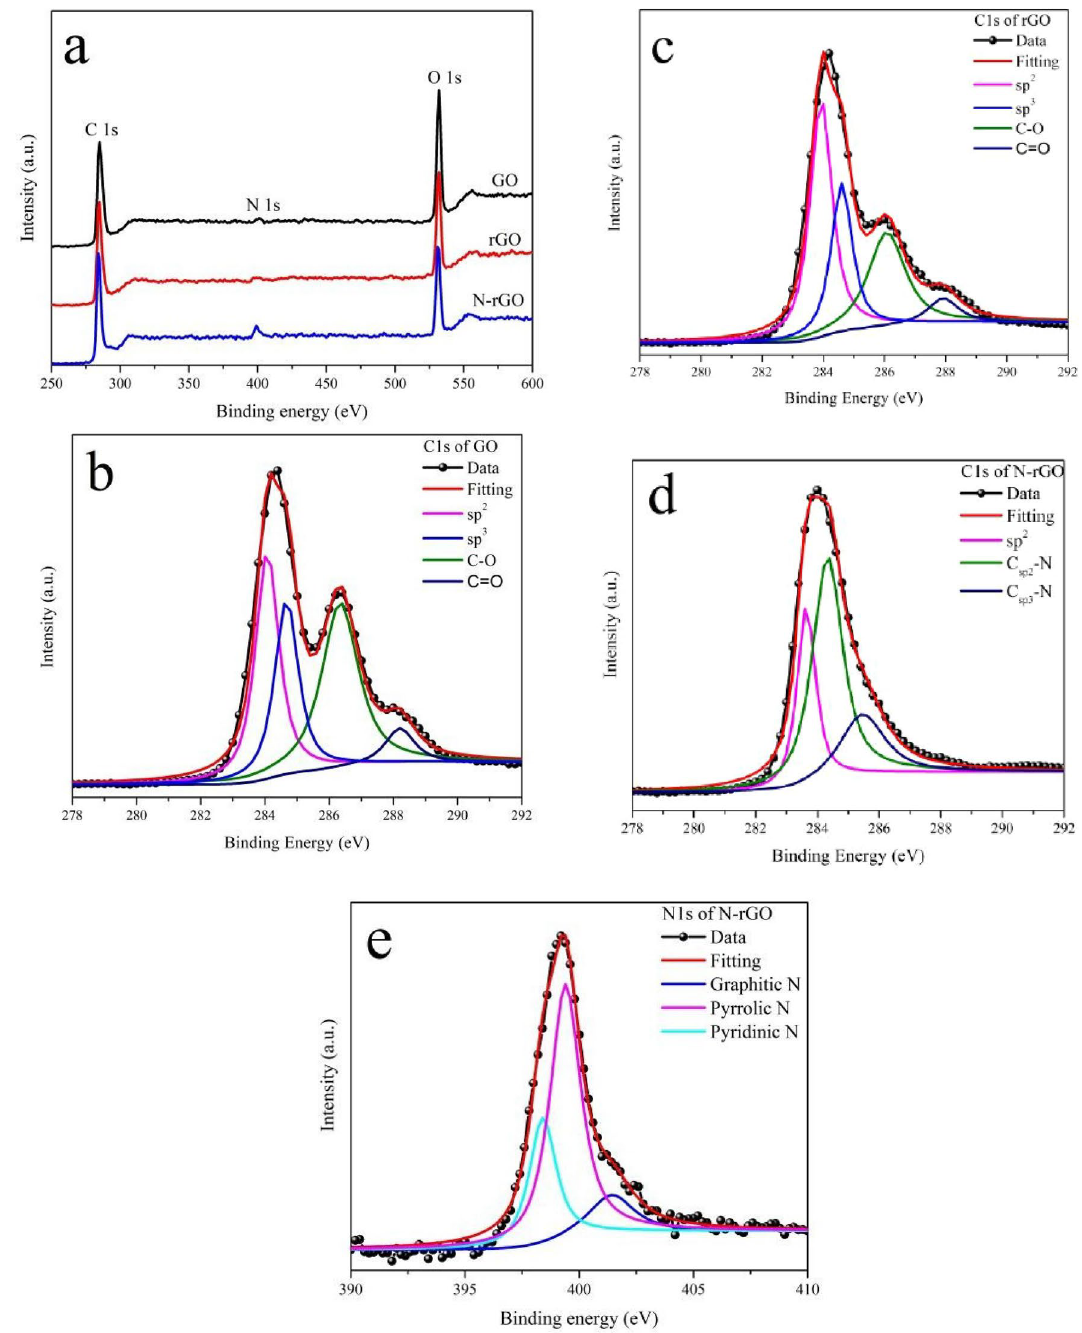
Figure 3. ( a ) XPS spectra of GO, rGO, and N-rGO; ( b ) C1s peak of GO; ( c ) C1s peak of rGO; ( d ) C1s peak of N-rGO; ( e ) N1s peak of